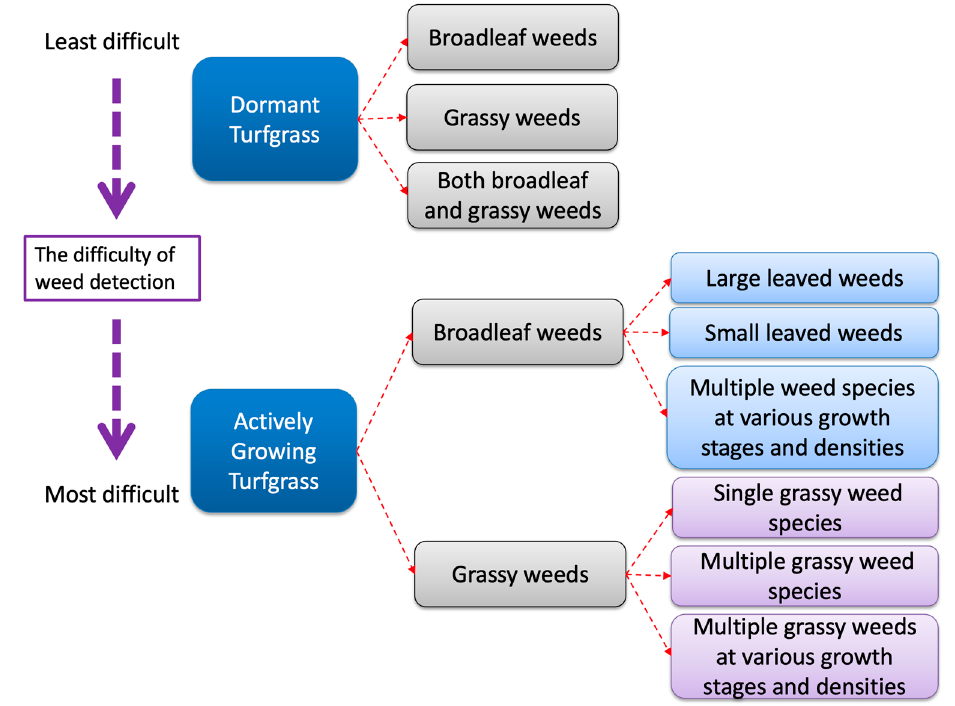
Figure 1. Presumed difficulty of using DCNNs for detecting weeds growing in turfgrass.